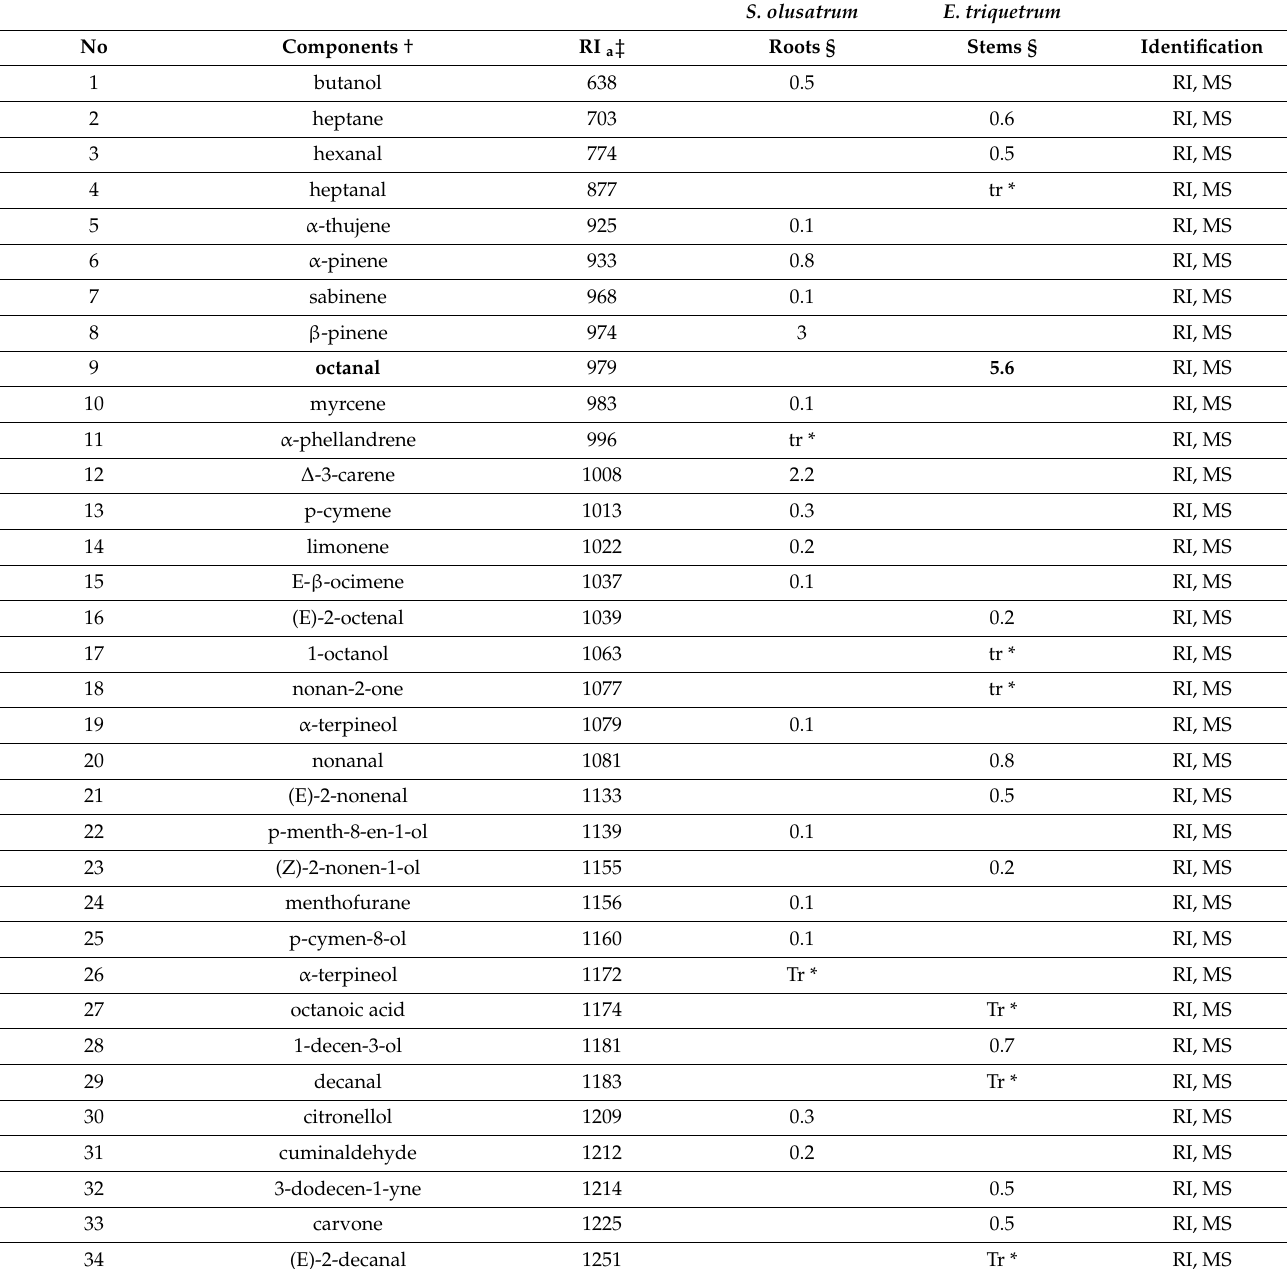
Table 1. Chemical composition of S. olusatrum and E. triquetrum essential oils from